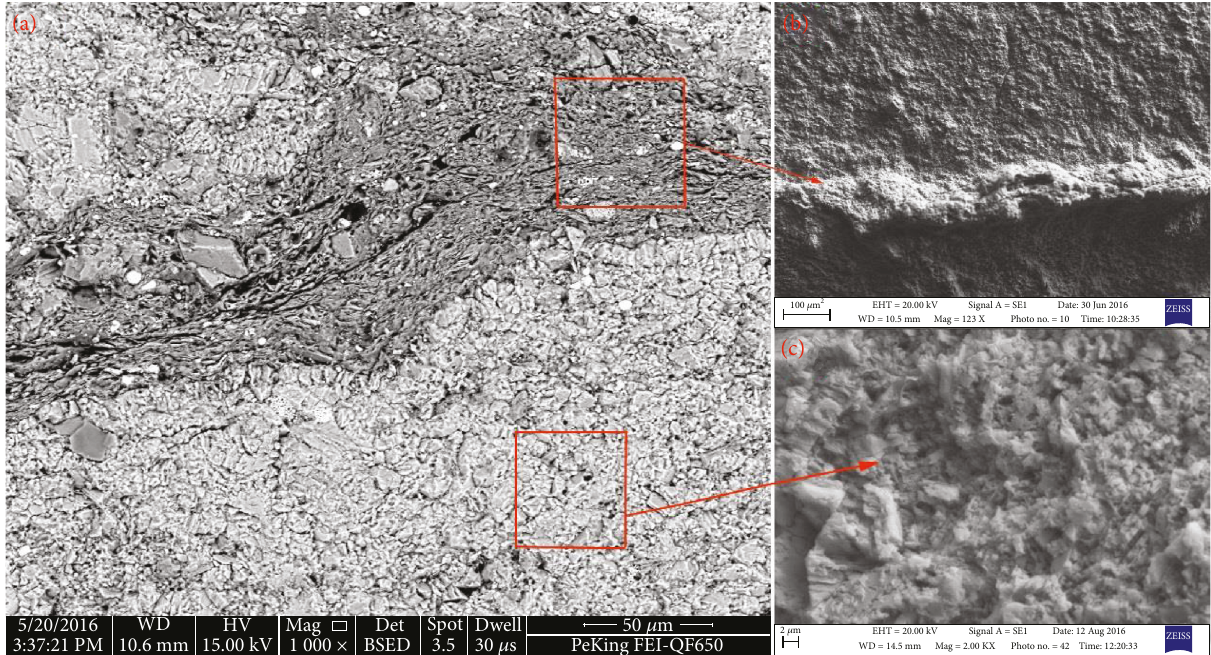
Figure 14: SEM photomicrographs of the calcite matrix and the later fi lling matter of S Detailed view of the later fi lling matter after the CFDE experiments. (c) Detailed view of the calcite particles after the CFDE